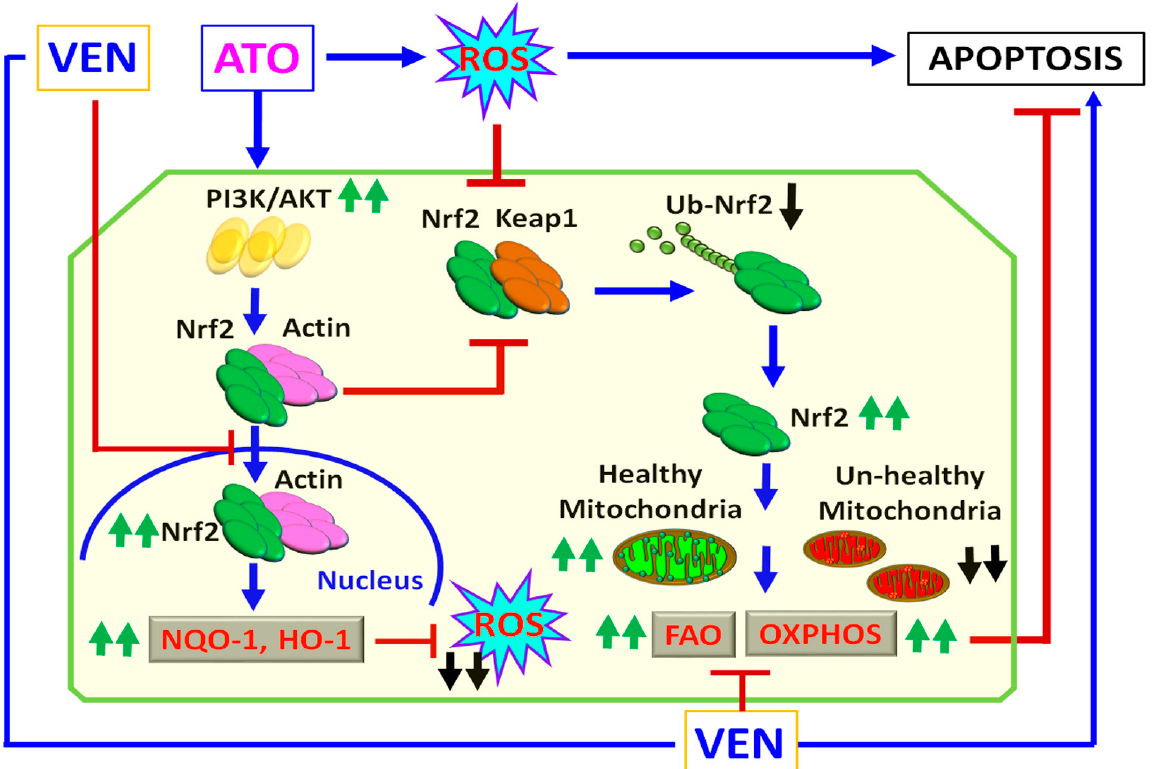
Figure 6. Antileukemic mechanism of ATO +VEN synergy. Schematic diagram of a proposed mechanism of synergy of combining ATO with VEN for targeting of metabolic vulnerabilities of LSCs. FAO, fatty acid oxidation; OXPHOS, oxidative phosphorylation; VEN, venetoclax; ATO, arsenic trioxide. Blue arrows, activation; red lines, inhibition; green arrows, increase; black arrows, decrease.